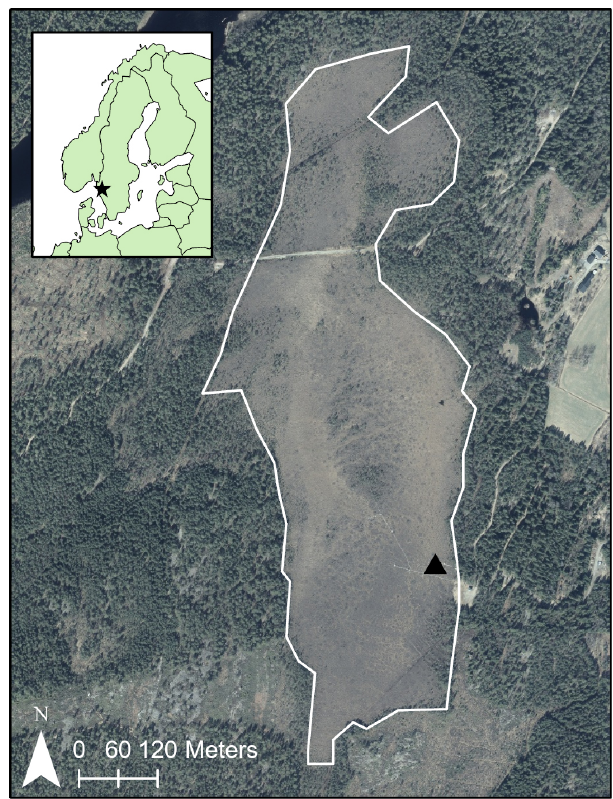
Figure 3. Map of Mycklemossen (outlined in white). The black star indicates the location of Mycklemossen within Scandinavia; the black triangle indicates the location of the chamber and NBLA measurements. Data sources: © Lantmäteriet, © EuroGeographics.